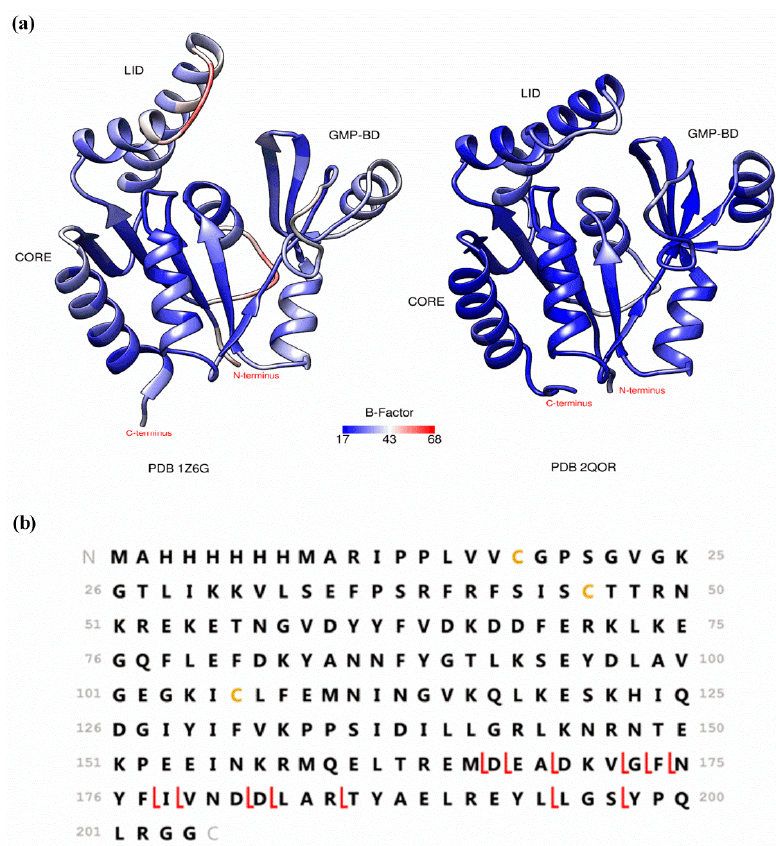
Figure 2. ( a ) Crystal structure of Plasmodium falciparum guanylate kinase ( Pf GK) (PDB 1Z6G) and Pv GK colored by average residue B-factor; ( b ) amino acid sequence of Pv GK and the assigned cleavage sites after ECD of Pv GK analyzed under native conditions (10 mM ammonium acetate solution).